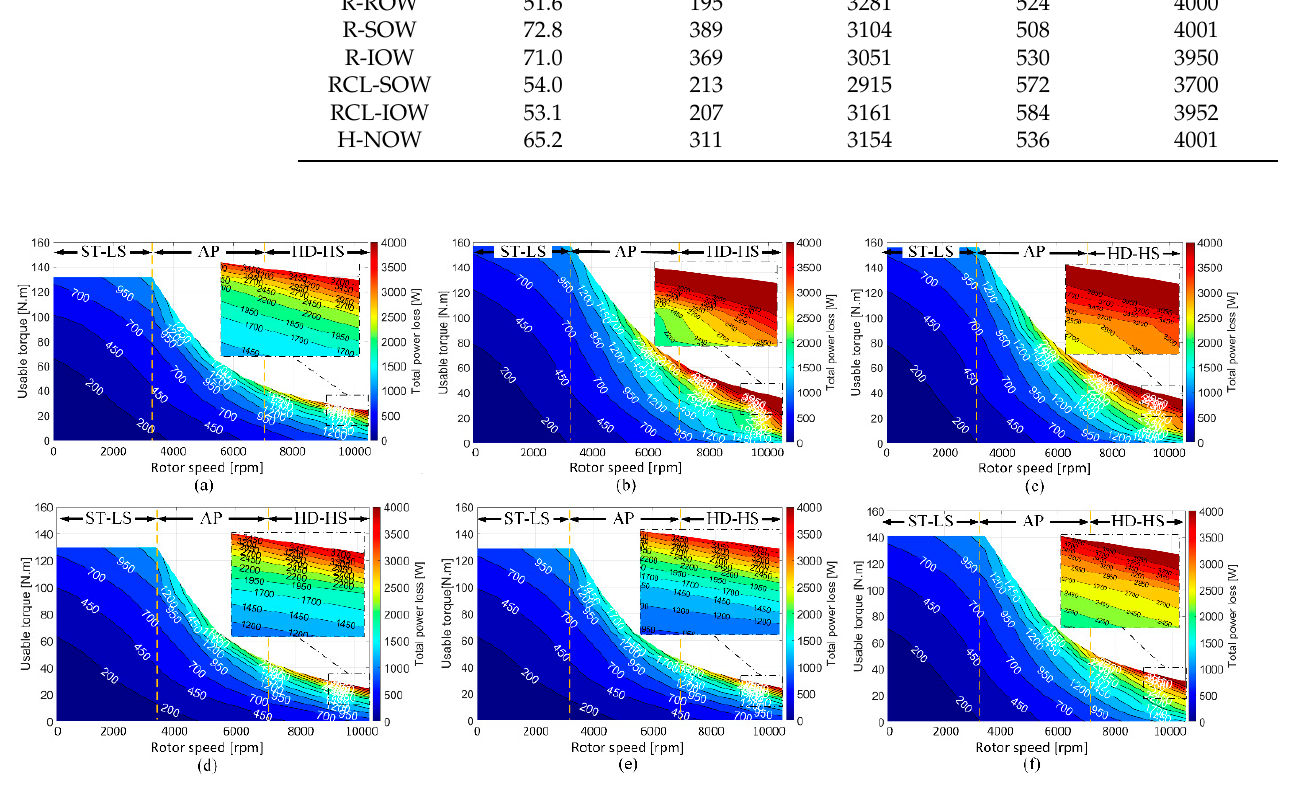
Figure 6. Total loss maps for the IPMSM with ( a ) R-ROW, ( b ) R-SOW, ( c ) R-IOW, ( d ) RCL-SOW, ( e ) RCL-IOW, and ( f ) H-NOW arrangements.